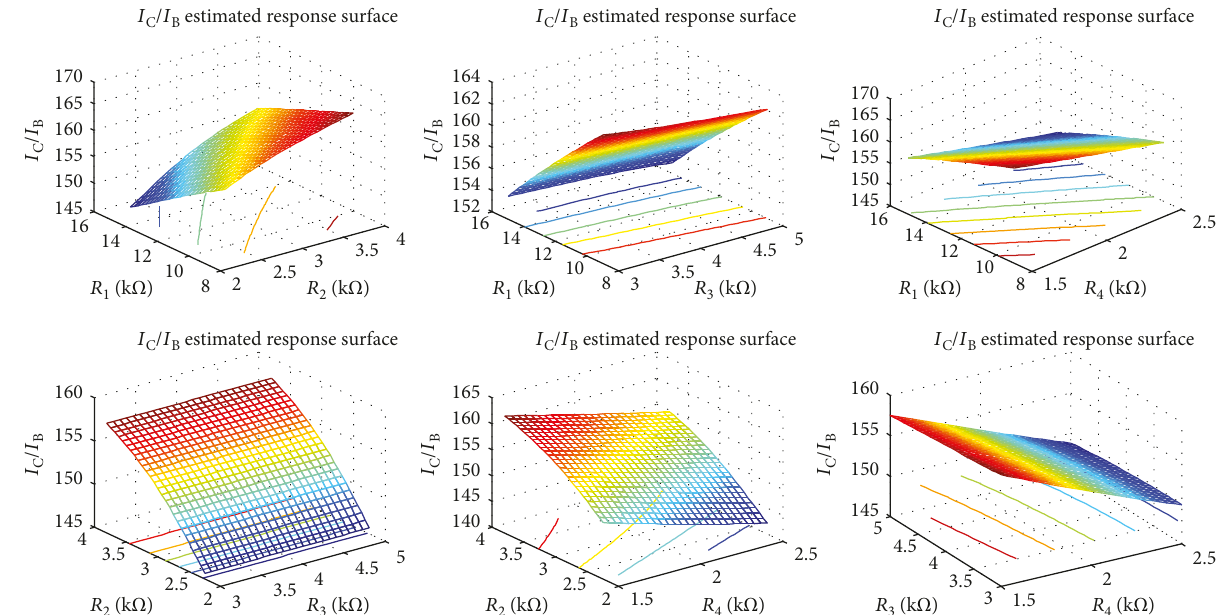
Figure 5: Estimated ANN response surface for the I